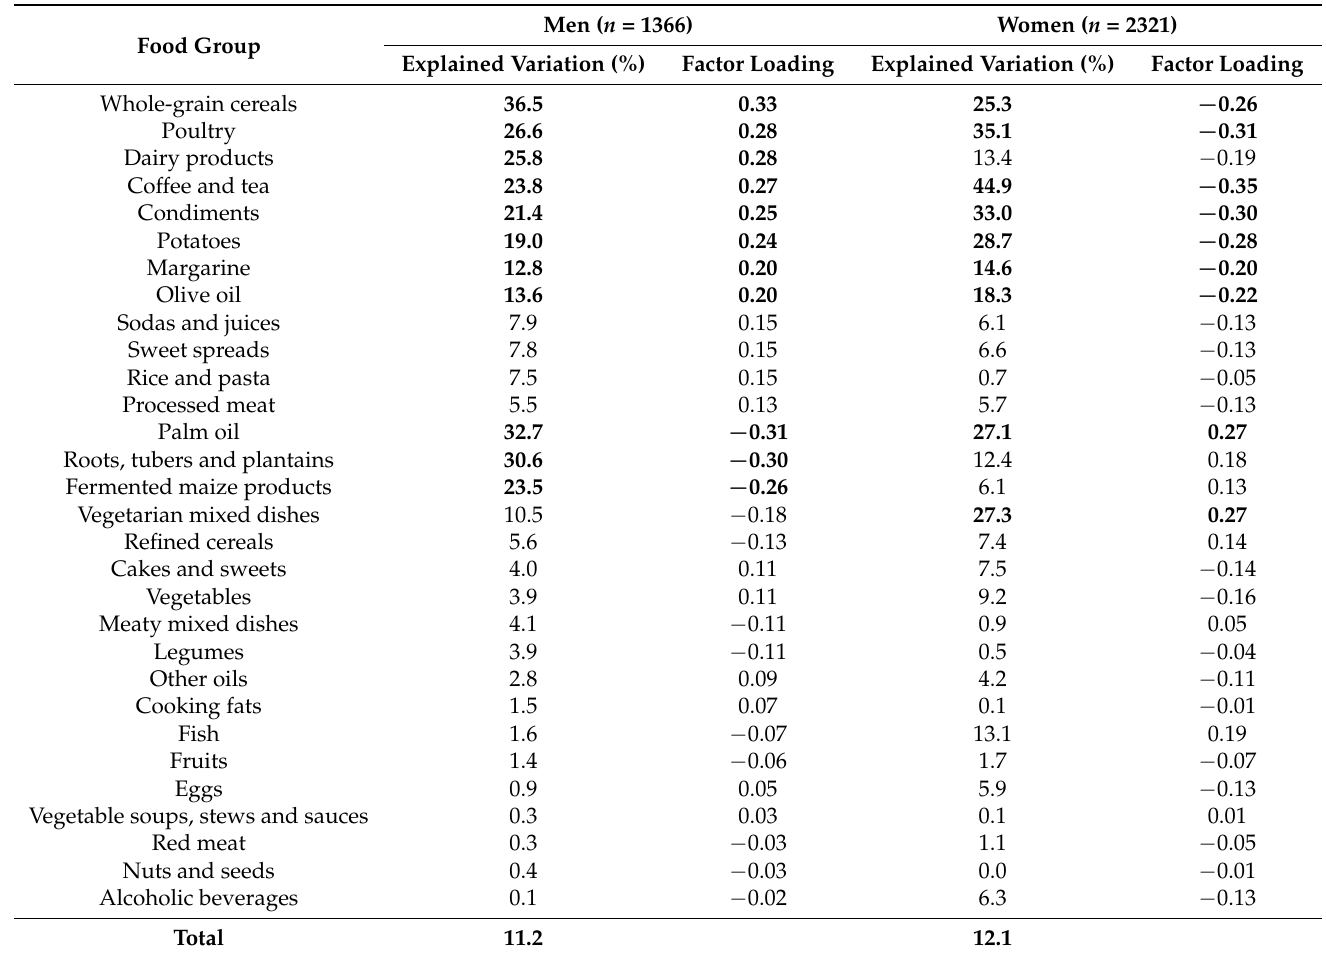
Table 4. Percentage of explained variation in food intake and factor loadings of 30 food groups of the RRR-derived dietary pattern scores related to NAFLD biomarkers among males and females 1 .